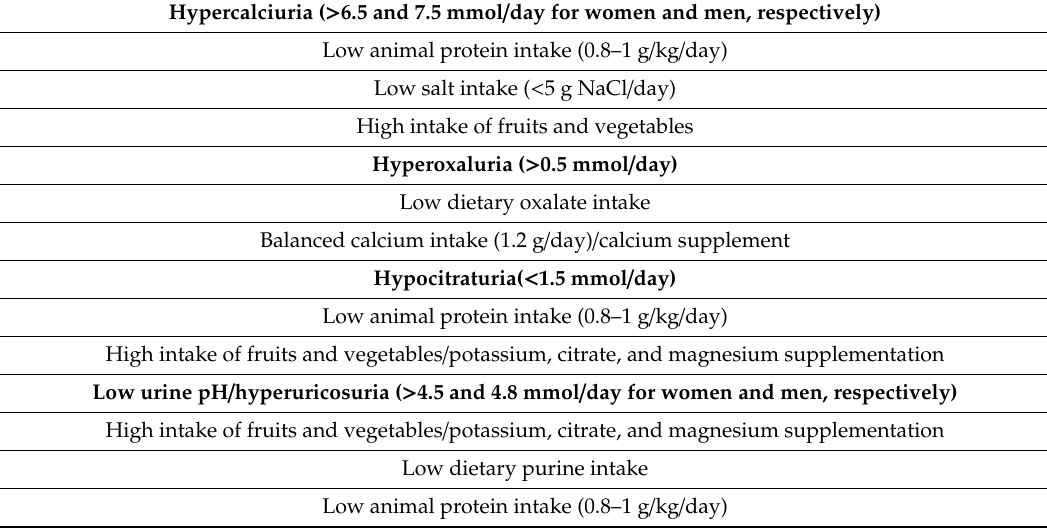
Table 2. Dietary advice for single 24 h urine